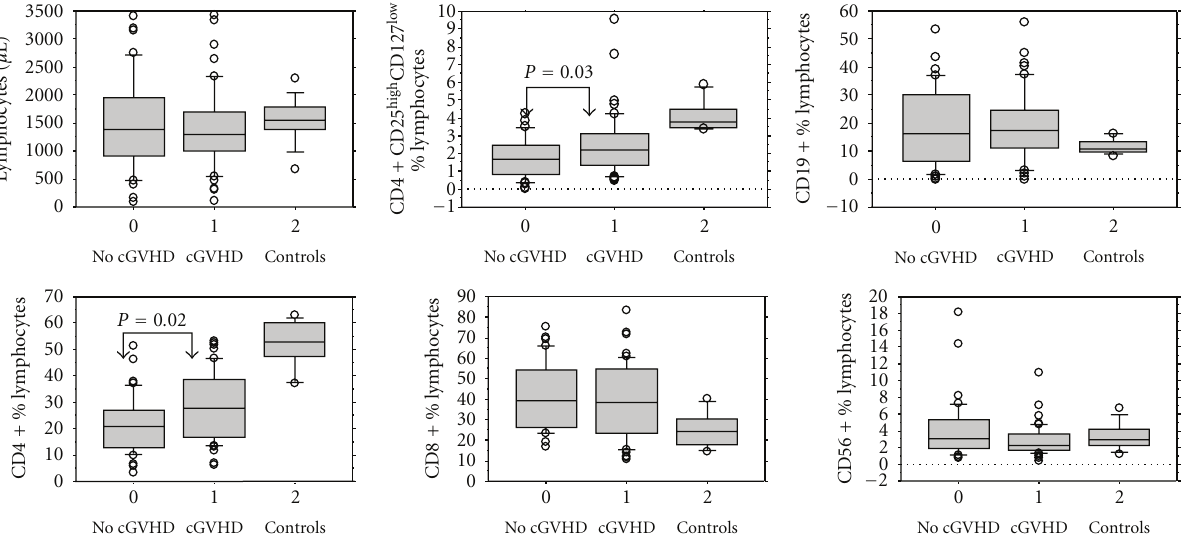
Figure 4: Lymphocyte subpopulations and Treg in patients with cGVHD and in patients without cGVHD. Box plot graphs of lymphocyte subpopulation frequencies in patients and healthy controls. The graphs show the dispersion around the median for patients without cGVHD ( n = 38), for patients with cGVHD ( n = 46), and for normal controls ( n = 20). The line across each box represents the median, the bottom edge the first quartile, and the top edge the third quartile, the error bars represent the dispersion within the 95% confidence interval and the dots represent extreme values. Di ff erences between the groups were explored using the Mann-Whitney U -test. Significant di ff erences between the groups are shown above ( P < 0 . 05). All other di ff erences between the median values were not significant ( P > 0 . 05). CD: cluster of di ff erentiation, Treg: regulatory T cells, and cGVHD, chronic graft versus host